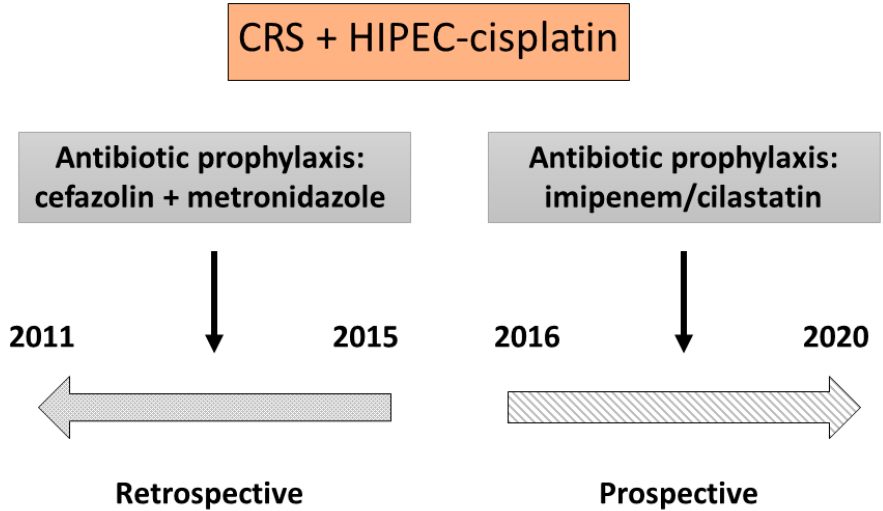
Figure 5. Time sequence of the study protocol. CRS, cytoreductive surgery; HIPEC, hyperthermic intraperitoneal chemotherapy.